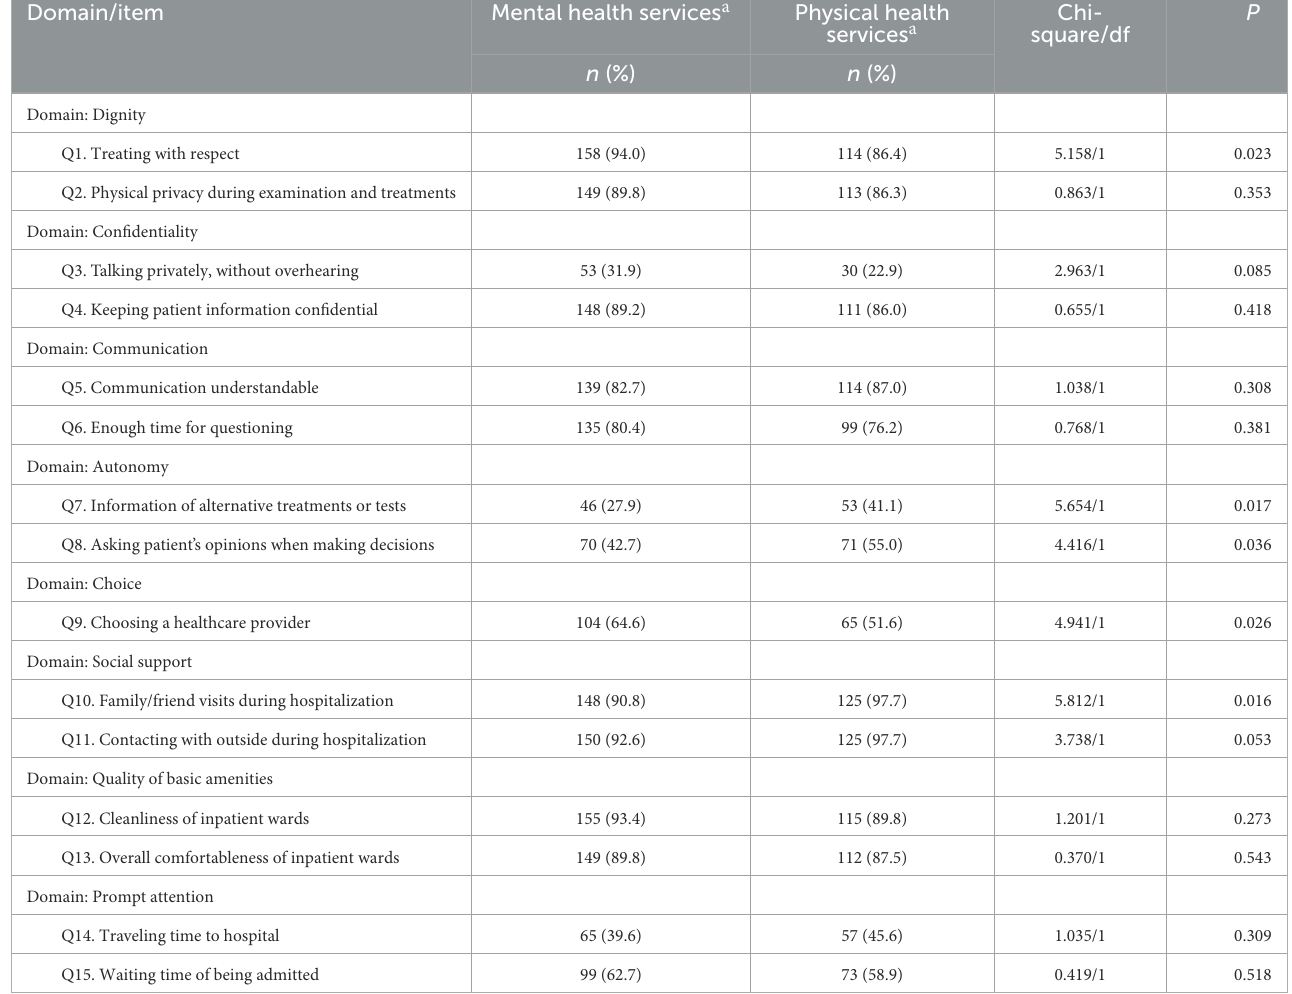
TABLE 2 Comparison of responsiveness performance ratings between mental health and physical health inpatient services.